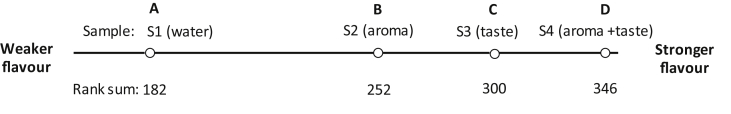
The perceived overall flavour intensities presented as rank sums for the four sample drinks (pairwise ranking test, n = 60). Samples without a same capital letter superscript are significantly different (p < 0.05).